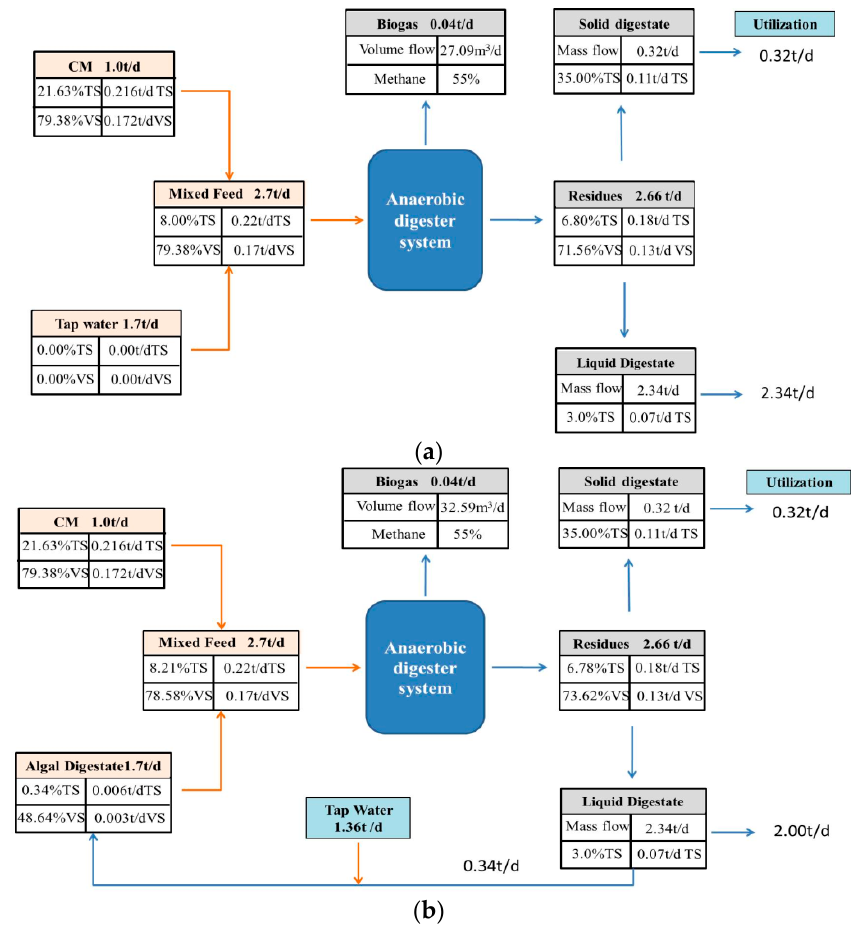
Figure 5. Mass flow of CM digestion with TW ( a ) and AW ( b ).